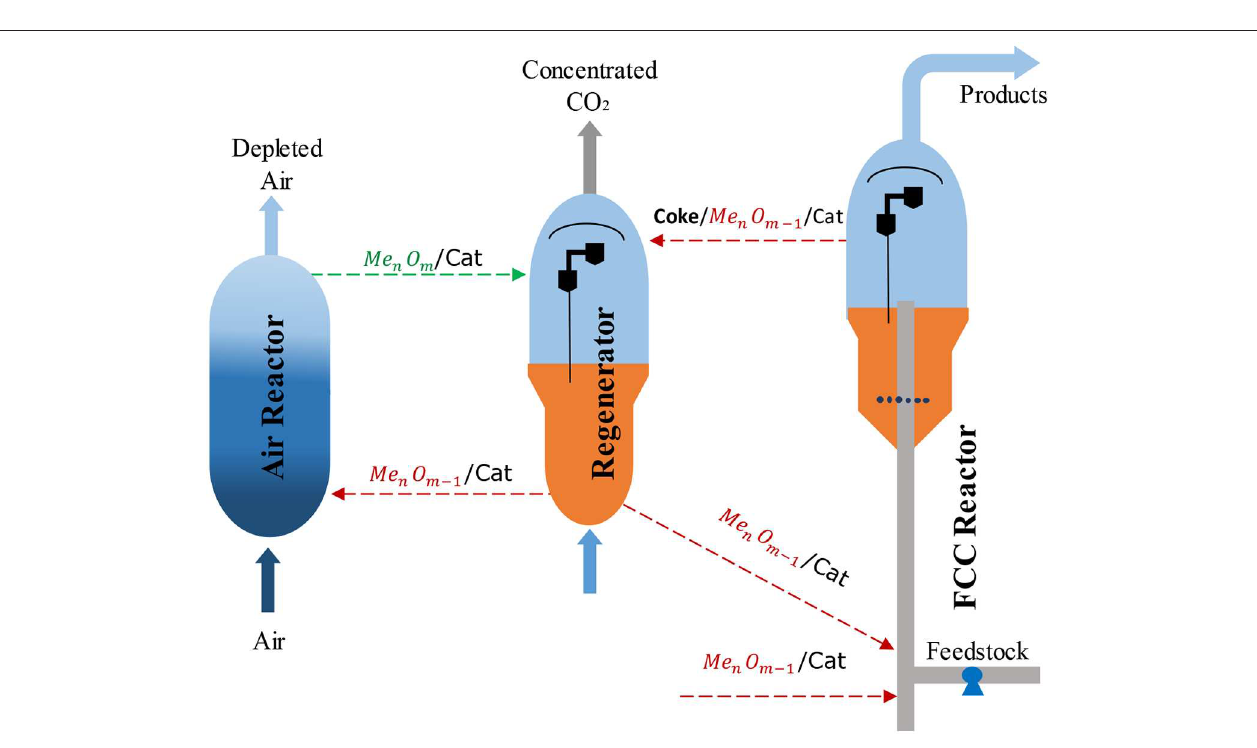
combustion (Cao et al., 2006; Adanez et al., 2012). Also, the gas leaving from the air reactor can also be expected to be essentially free of NO x (Lyngfelt,